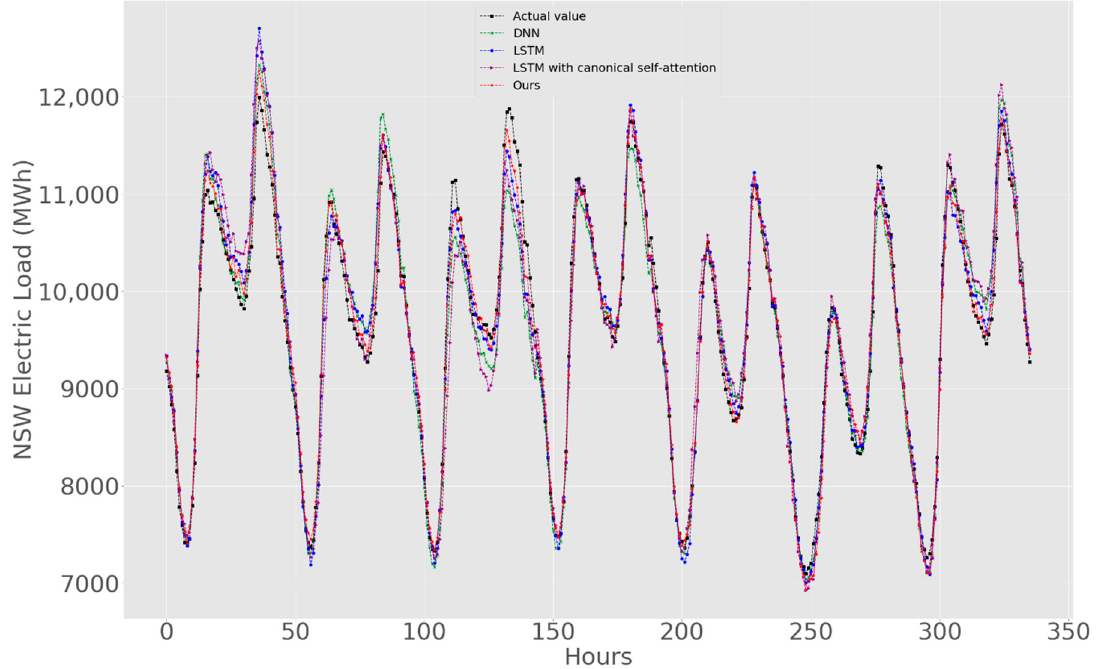
Figure 11. Forecast results of NSW (New South Wales) electricity load .